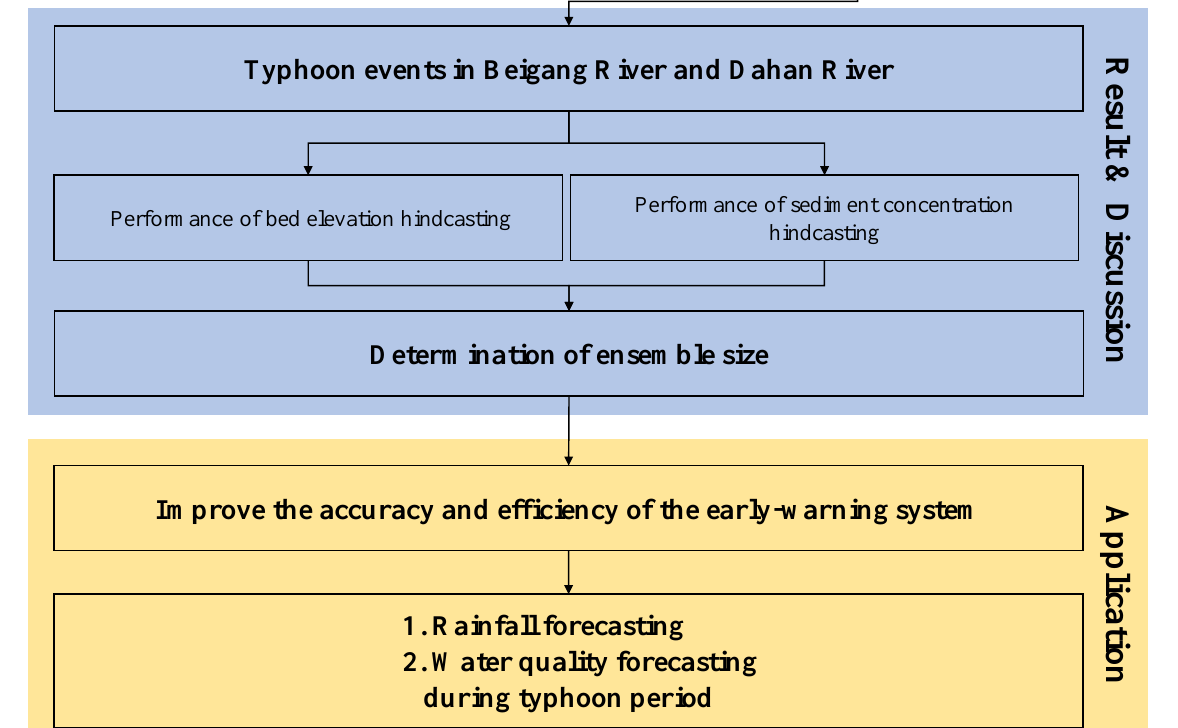
Figure 1. Flowchart of the proposed approach.